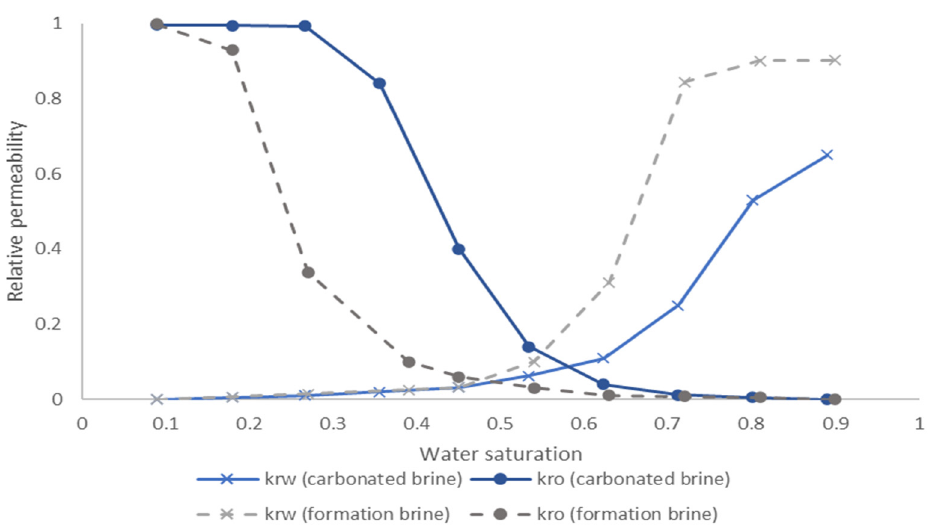
Figure 8. Imbibition relative permeability curves for water (gray) and carbonated brine (blue) injection in the oil-saturated coquina sample.